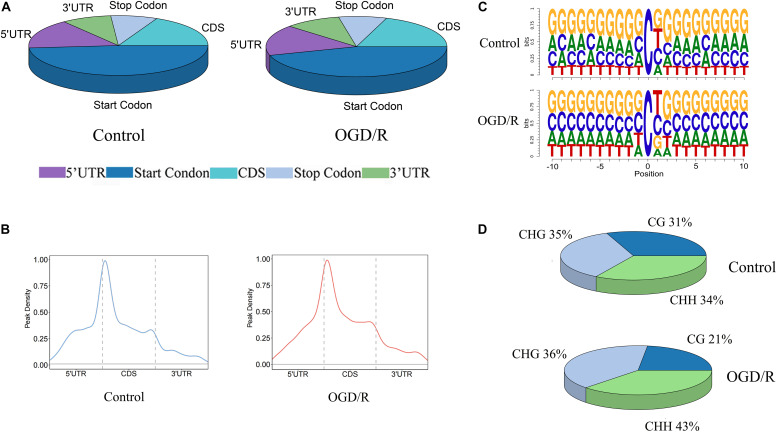
The distribution patterns of m5C sites of mRNA. (A) Pie chart of the distribution of m5C sites in the indicated regions (B) The peak density of mRNA m5C sites distributed along mRNA transcripts. The dashed lines represent the translational start and stop codons. (C) Sequence frequency logo of the sequences close to the mRNA m5C sites of the two groups. (D) Proportions of mRNA m5C sites in each sequence context: CG, CHG and CHH, where H = A, C, or U.